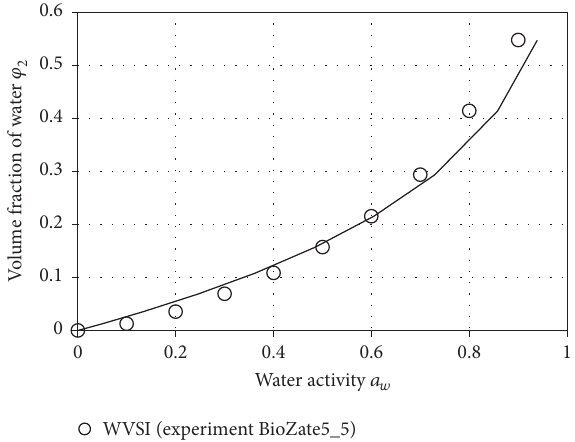
Figure 1: Water vapor sorption isotherm (WVSI) of the sample BioZate5 5 and the calculated sorption isotherm by the Flory- Huggins (FH)